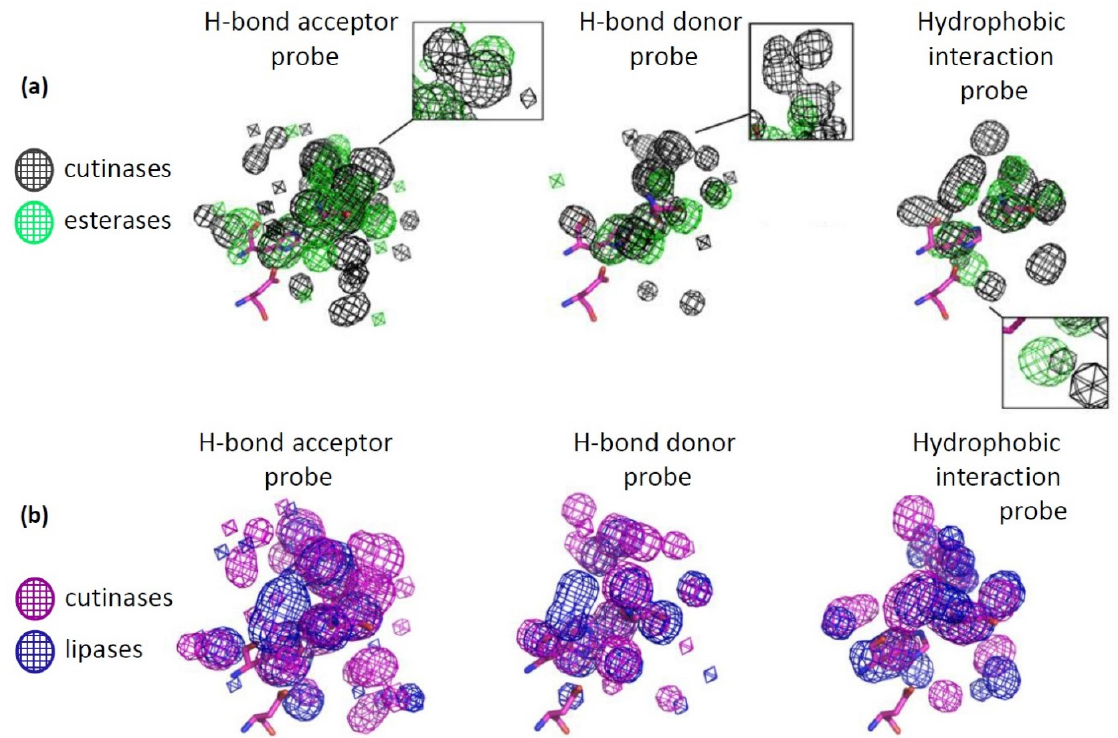
Figure 5. Superimposition of the catalophores of ( a ) cutinases (black) and esterases (green); ( b ) cutinases (pink) and lipases (blue). Reference residues composing CaLB catalytic triad are highlighted.